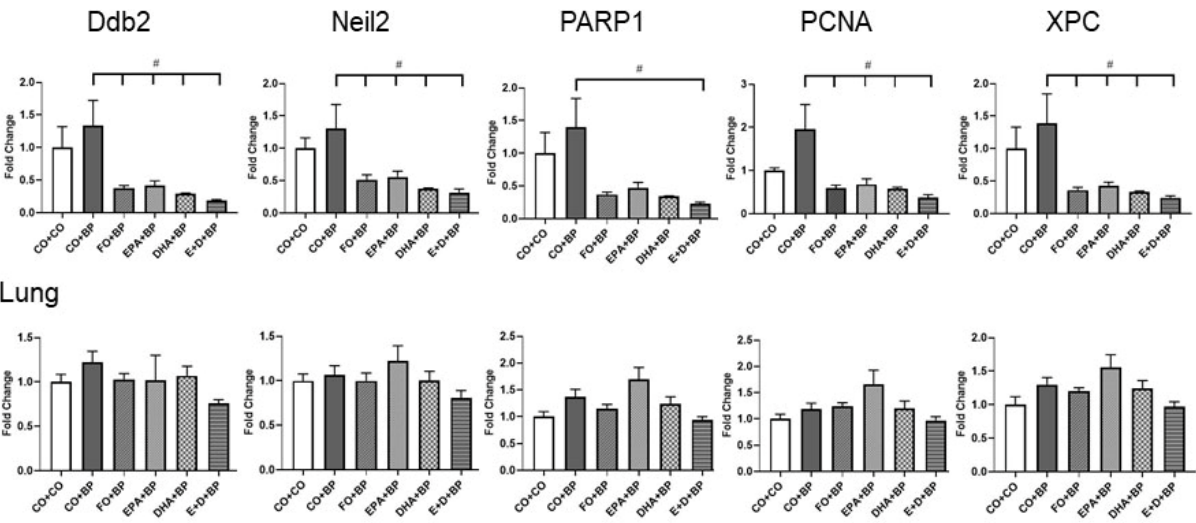
Figure 8. Effects of BP and omega-3 fatty acids on liver and pulmonary DNA repair gene expressions. Quantitative polymerase chain reaction measurement of Ddb2 , Neil2 , Parp1 , Pcna , and Xpc mRNA expression in lung of A/J mice as stated in Materials and Methods. Data are shown as mean ± SEM values by Anova analysis. Significant differences between CO+BP and omega-3 fatty acids + BP are indicated by #, p < 0.05 ( n = 5).